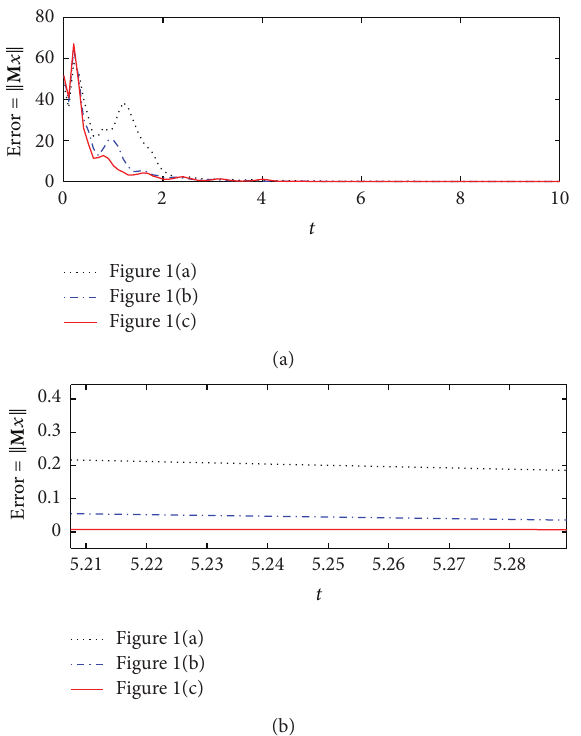
Figure2:Synchronizationerrors ‖ M 𝑥 ‖ ofthreenetworksinFigure 1.